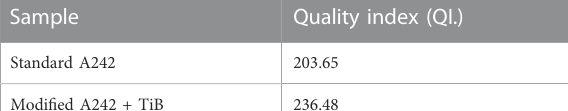
TABLE 2 Quality index of the investigated alloys. Sample Quality index